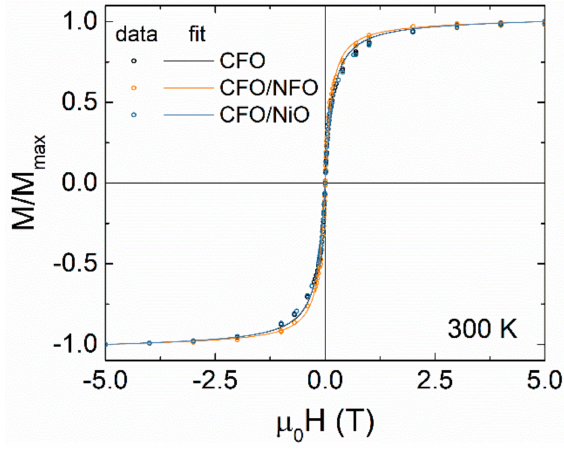
Figure 6. Measured and fitted with the Langevin–Chantrell method M-H cycles at 300